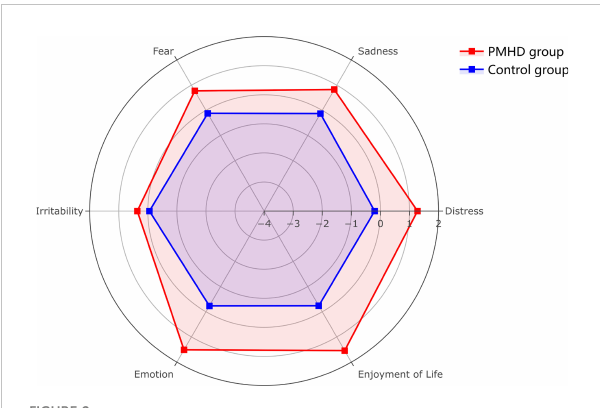
FIGURE 2 Radar plot of six indicators of postoperative mental health disturbances in the PMHD and control groups. The fi gure shows the mean values of the six indicators after standardization (patients with PMHDs in red, controls in